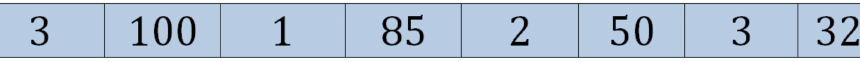
Figure 10. Example of a particle generated by PSO.